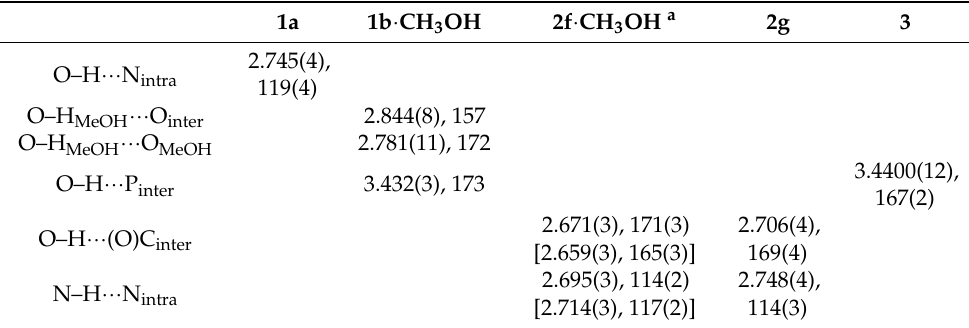
Table 3. Selected data ( D ··· A /Å, ∠ D –H ··· A / ◦ ) for key inter- and intramolecular contacts for com- pounds 1a , 1b · CH 3 OH , 2f · CH 3 OH , 2g , and 3